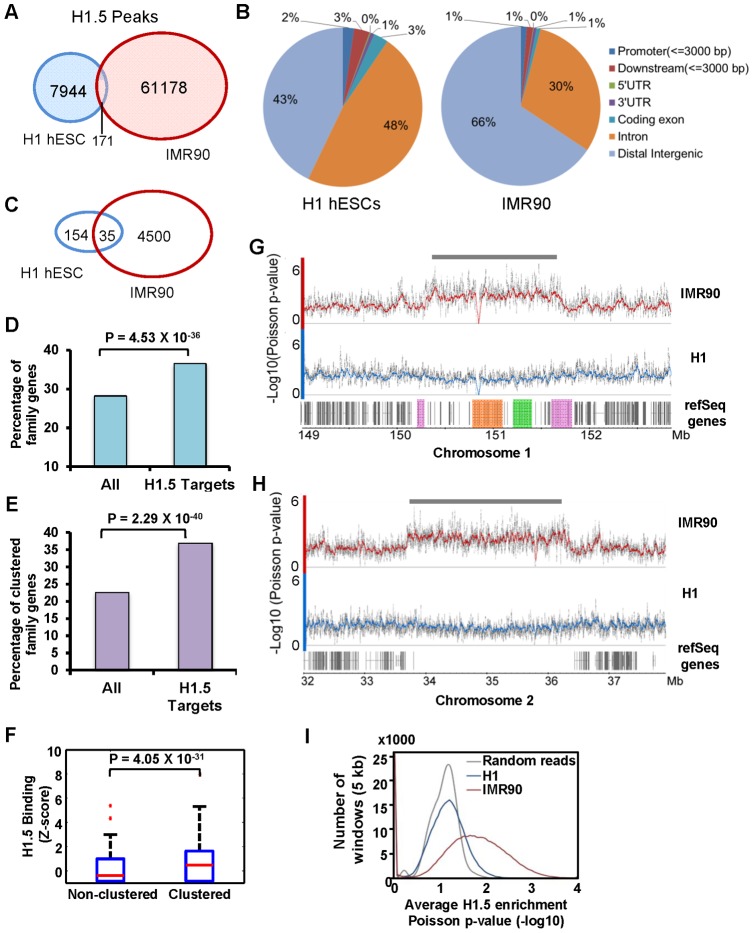
Histone H1.5 is differentially distributed in fibroblasts and embryonic stem cells.(A) Venn diagram of significant peaks of H1.5 binding in H1 hESCs and IMR90 fibroblasts by ChIP-seq. (B) Pie chart of distribution of H1.5 relative to gene structure in H1 hESCs and IMR90 fibroblasts. (C) Venn diagram of number of H1.5 target genes in H1 hESCs and IMR90 fibroblasts. (D) Enrichment of HGNC gene family members in H1.5 target genes. Height of bars represents percentage of gene family members in all RefSeq genes (left) or H1.5 target genes (right). (E) Enrichment of clustered gene family members in H1.5 target genes. Height of bars represents percentage of clustered gene family members in all RefSeq genes (left) or H1.5 target genes (right). (F) Box plot of H1.5 enrichment levels of non-clustered gene family members (left) and clustered gene family members (right). (G) H1.5 enrichment block at the LCE/SPRR/S100A gene clusters. Each dot represents −Log10 of Poisson p-value of ChIPed DNA versus input DNA in a 100-bp window. Lines represent average values. LCE, SPRR and S100A genes are highlighted in orange, green and pink, respectively. (H) An H1.5 enrichment block in an intergenic region of chromosome 2. (I) Histogram of average significance of H1.5 enrichment (x-axis) in 5 kb windows versus the number of windows (y-axis) in H1 hESCs and IMR90 fibroblasts.